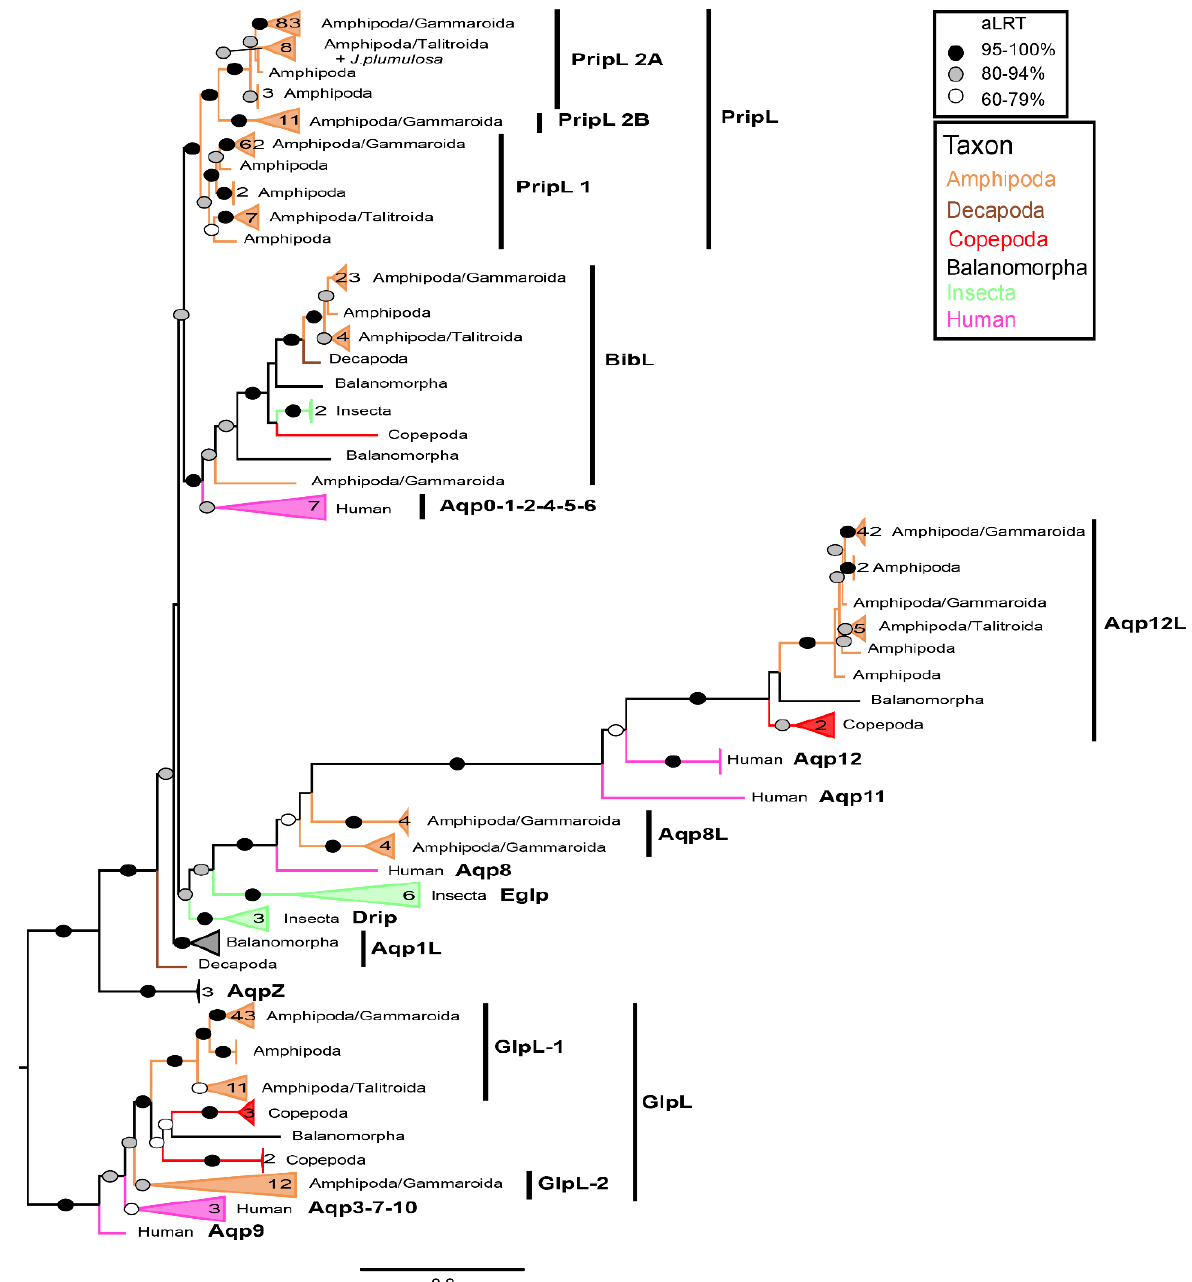
Figure 1. Maximum likelihood phylogeny of translated nonredundant sequences of AQPs. The number of sequences per collapsed clade reported beside it. Only aLRT support higher than 60% is shown (black: >95%; gray: 80–94%; white: 60–79%). Colors relative to the different taxa. The information relative to the sequences is available in Supplementary Table S1, as well as the complete alignment (Supplementary Alignment S1). See Supplement Figure S1 for the fully annotated